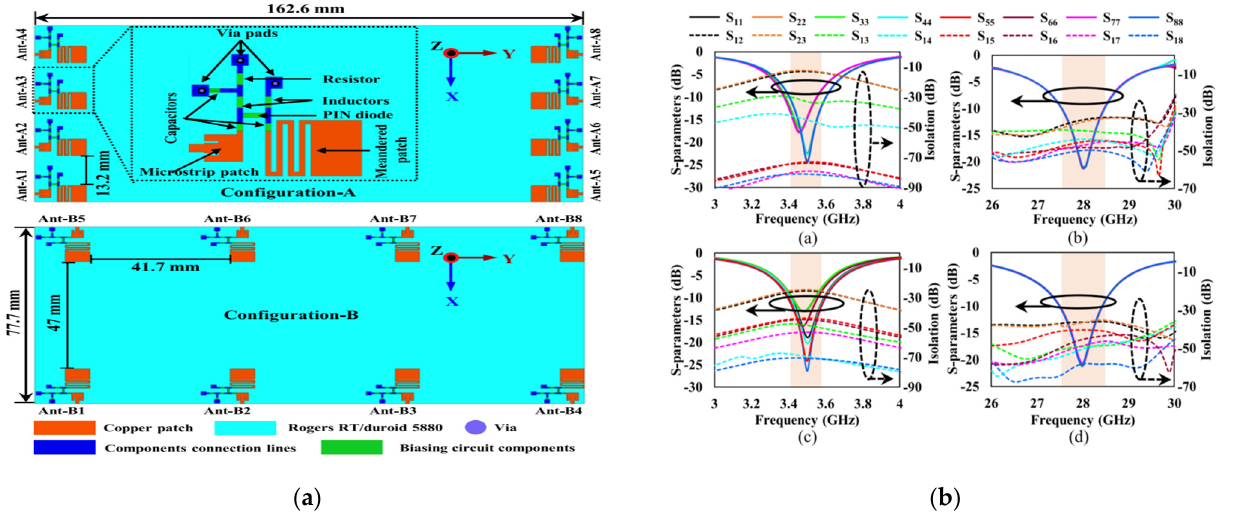
Figure 8. Antenna configurations ( a ) reconfigurable 8 × 8 MIMO system and ( b ) S11 parameters and isolation [11].